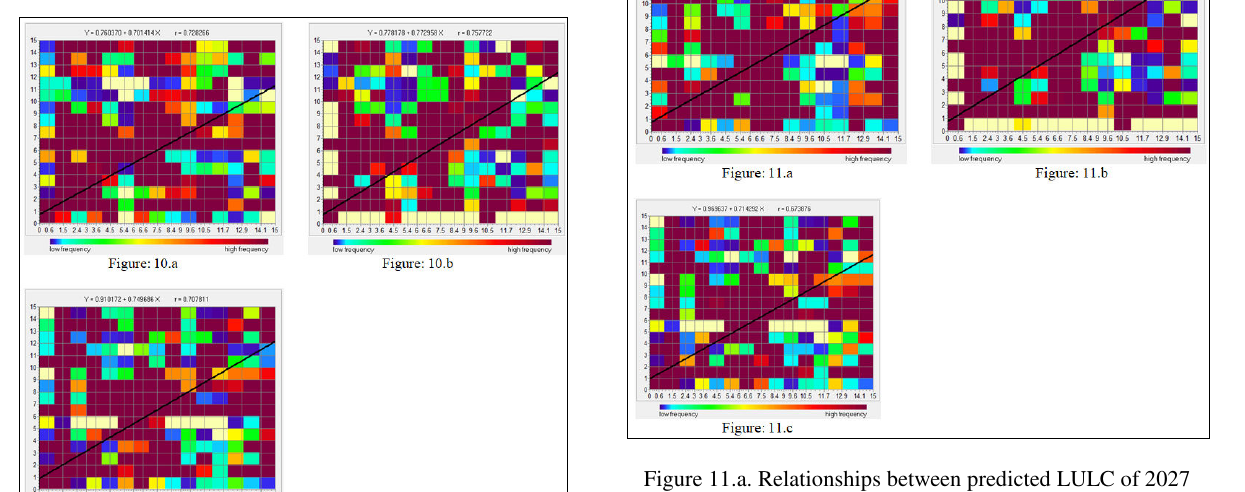
Figure 11.a. Relationships between predicted LULC of 2027 using 1987 & 1997 LULC image and predicted LULC of 2027 using 1997 & 2007 LULC image; Figure 11.b: Relationships image; Figure 11.c: Relationships between predicted LULC